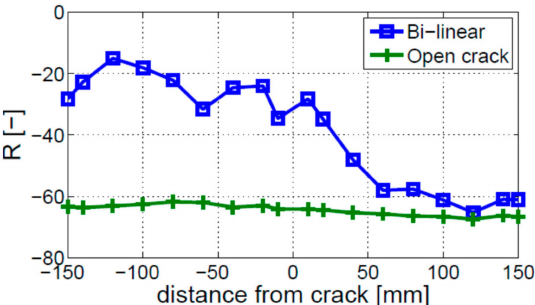
Figure 11. Distribution of modulation intensity coefficient R along the beam for the open crack model used in numerical simulation. The results are compared with the bi-linear crack model.